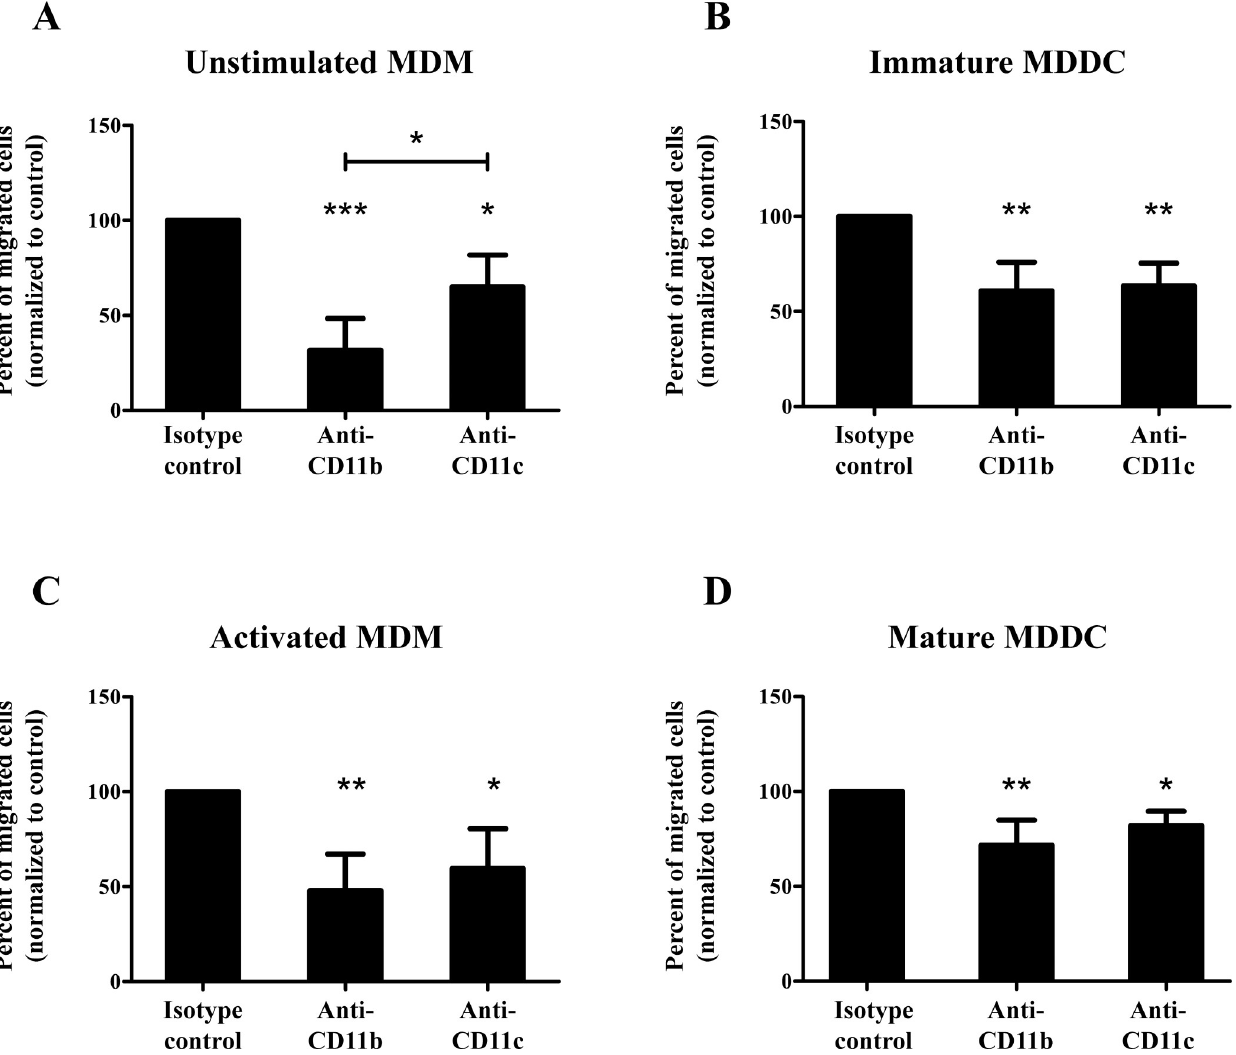
Fig 6. Analysis of the migration of MDMs and MDDCs using FMLP or CCL19 as a chemoattractant. FMLP was used as a chemoattractant for unstimulated MDMs (A) and immature MDDCs (B), and CCL19 was applied for activated MDMs (C) and mature MDDCs (D). Cells were treated with either anti-CD11b or anti-CD11c ligand binding site specific antibodies before migration, and the number of transmigrated cells were counted by flow cytometry after detachment using EDTA. The number of migrated cells was normalized to the isotype control antibody treated samples, shown as 100%. One-way ANOVA with Tukey’s post-test was used to determine significant differences compared to control, � = p < 0.05; �� = p < 0.01, ��� = p < 0.001.